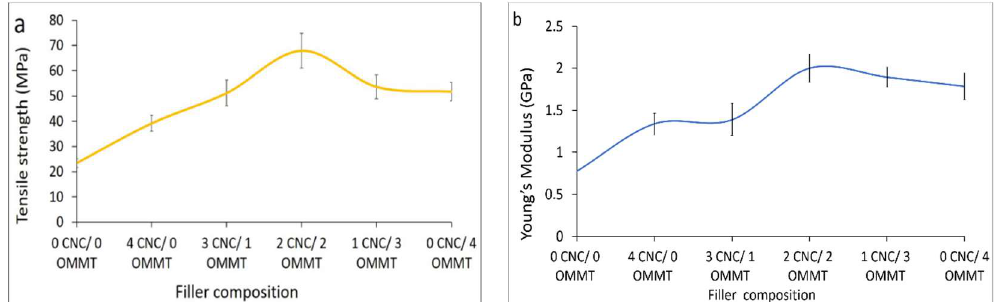
Figure 2. Cellulose nanocrystal (CNC) and organically modified montmorillonite (OMMT) hybridization effects on ( a ) tensile strengths; and ( b ) Young’s modulus of hybrid